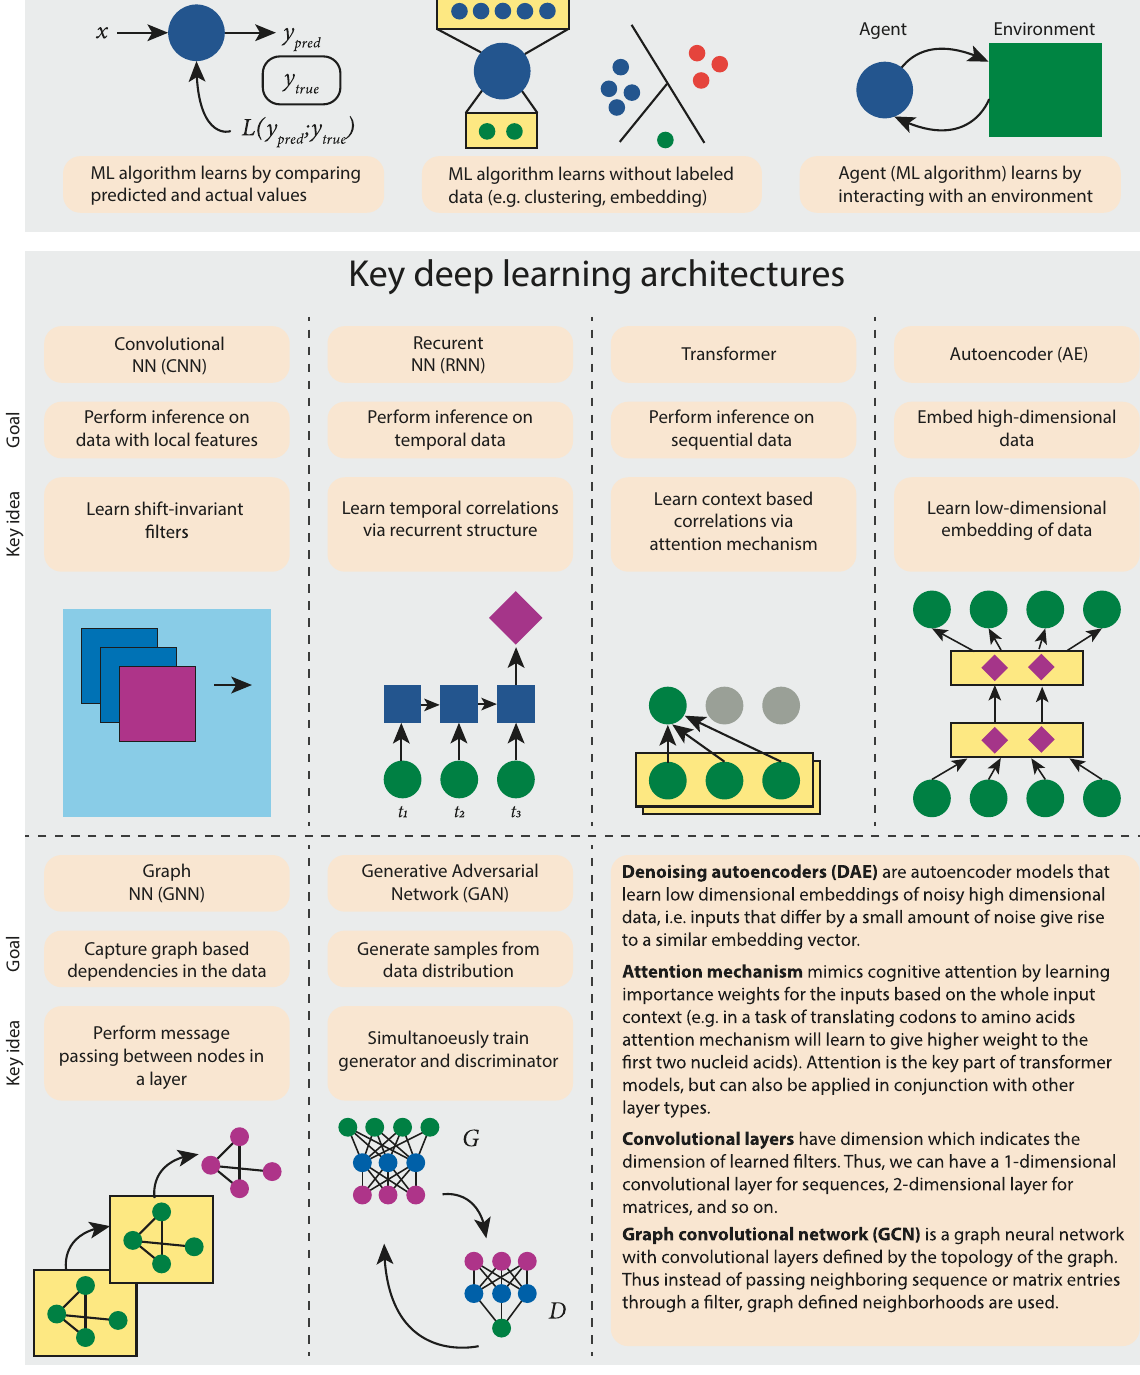
Fig. 1 An overview of machine learning scenarios and commonly used DL architectures. Top panel encapsulates the three most common paradigms of machine learning: supervised learning in which dataset contains ground truth labels, unsupervised learning in which dataset does not contain ground truth labels, and reinforcement learning in which an algorithmic agent interacts with a real or simulated environment. The bottom panels provide an overview of the most prevalent DL architecture ideas each designed to achieve speci fi c highlighted goals. An additional set of short descriptions is provided for other common components of DL architectures mentioned in the